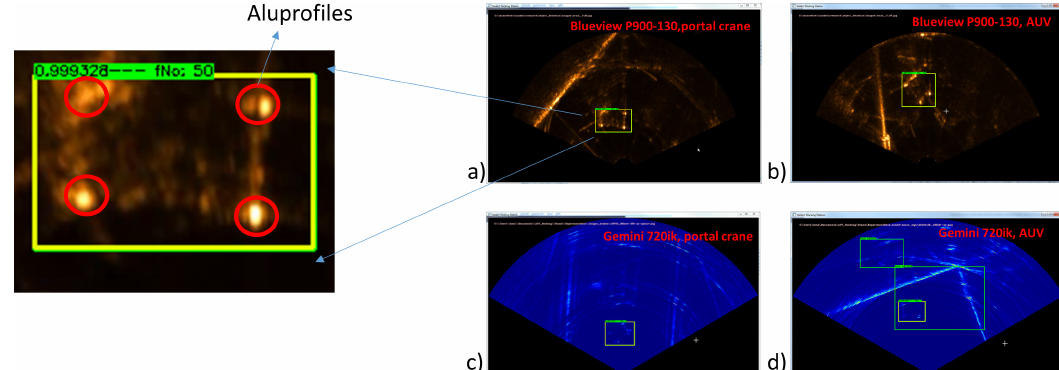
Figure 13. Example results Test 1: true positives with tight bounding boxes independent of the hardware ( a ) Blueview sonar on portal and ( b ) Blueview sonar on AUV ( c ) Gemini sonar on portal and ( d ) Gemini sonar on AUV.